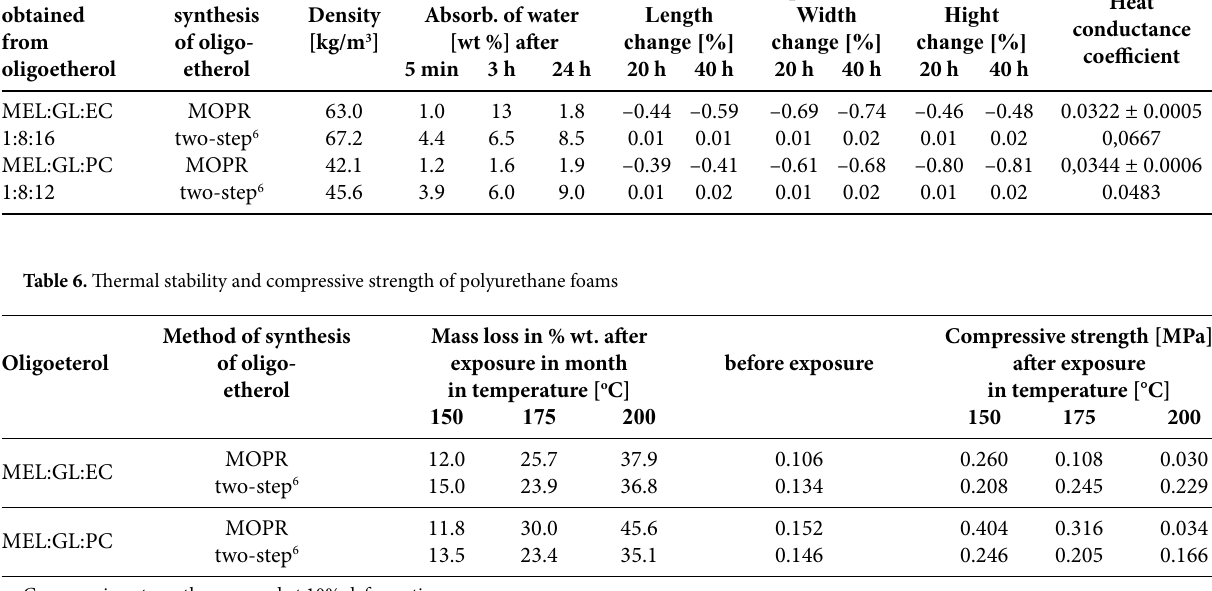
Table 5. Some properties of polyurethane foams Foam Method of